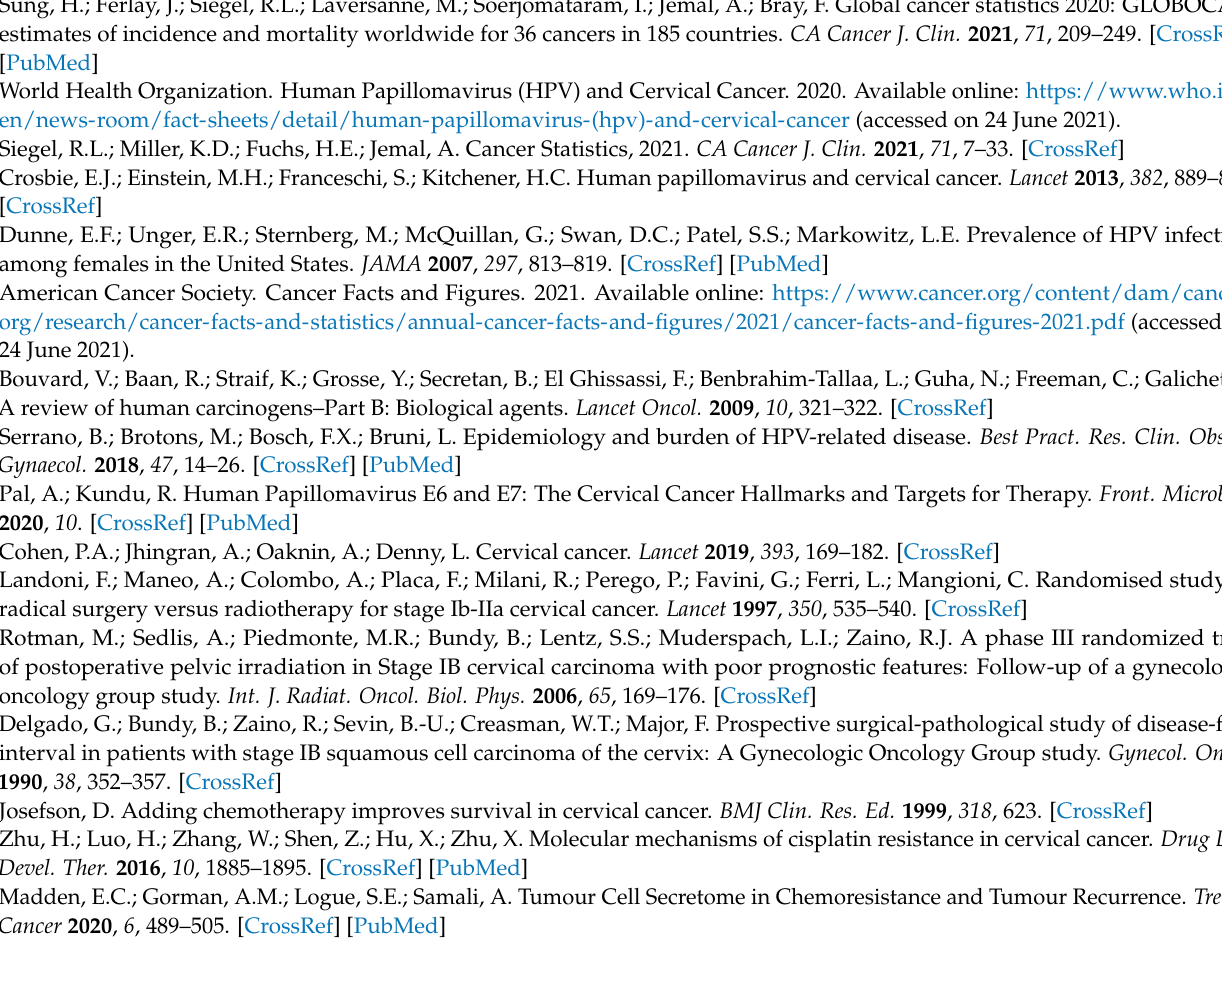
Figure S1. The efficacy of DML6 in HeLa cancer